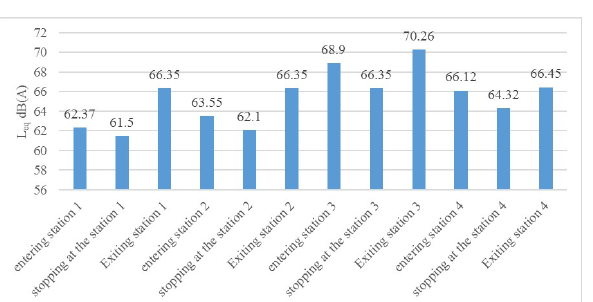
Figure 3: L eq values of 4 stations in the operator